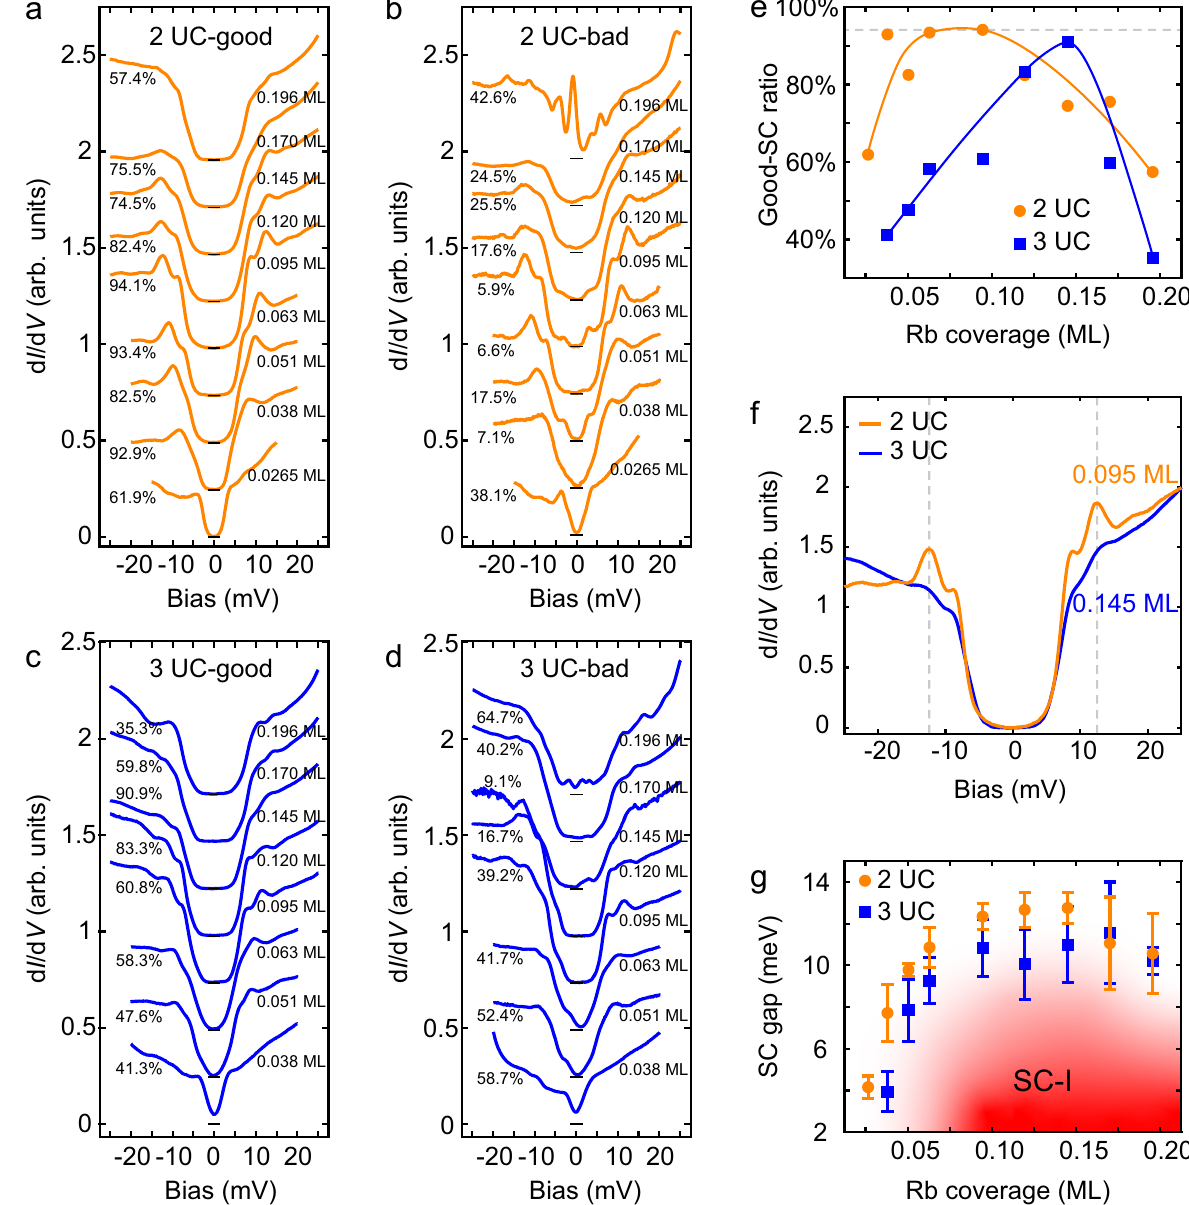
Fig. 4 Superconductivity induced by Rb surface doping in 2 UC and 3 UC FeSe thin fi lms. a , b Doping dependence of averaged d I /d V spectra taken on 2 UC FeSe with good and bad superconducting gaps, respectively. c , d Doping dependence of averaged d I /d V spectra taken on 3 UC FeSe with good and bad superconducting gaps, respectively. Here, symmetric coherent peaks and absence of in-gap state are the criteria for good superconducting gap. In opposite, the spectra which show asymmetric superconducting gap or in-gap states are sorted into the bad superconducting group. e The dependence of good- superconductivity ratio on Rb coverage. Here, the ratio is de fi ned as the proportion of the d I /d V spectra showing good superconducting gap at each Rb coverage. The higher ratio indicates better homogeneity. The curves are guides to the eye. f Averaged d I /d V spectra extracted from ( a ) and ( c ) at the doping levels with the optimal homogeneity in 2 UC and 3 UC FeSe. g Dependence of the superconducting gap size on Rb coverage. The spectra in good superconducting group are taken into statistics. The error bars denote the standard deviations of superconducting gap sizes at different Rb